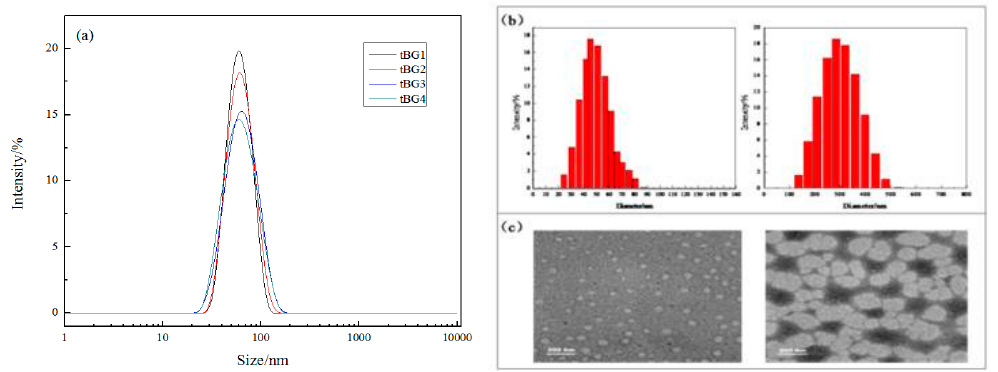
Figure 6. Size distributions of tBGs aqueous solutions ( a ), measured by DLS at 25 and 37 °C ( b ), and TEM images of tBG4 micelles at 25 and 37 °C ( c ).